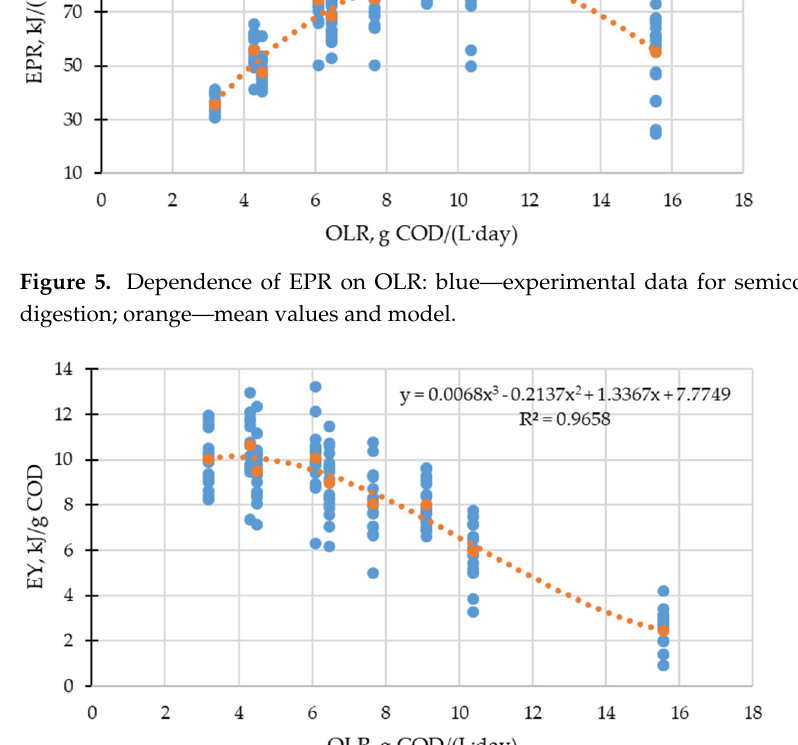
Table 4. Experimental design of the